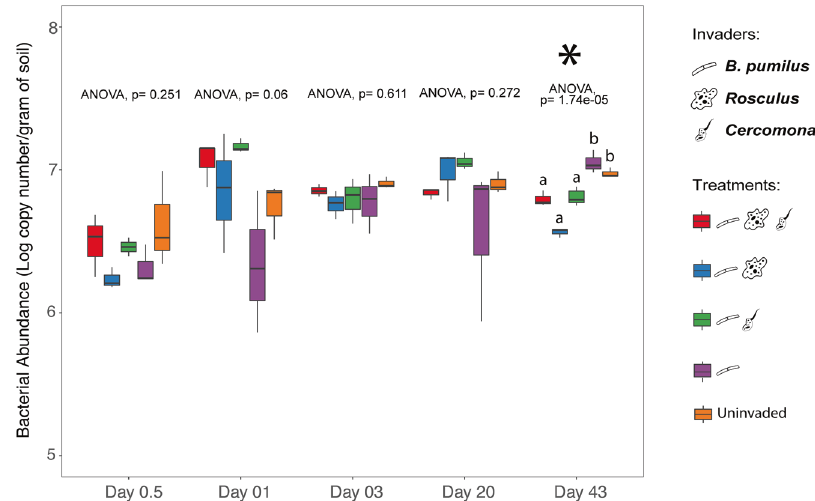
Fig. 5 Temporal dynamics of the total soil bacterial abundance between treatments in the Bacillus pumilus experiment. Values represent qPCR results in the log of 16S rRNA gene copies per gram of soil. Bars represent the standard error of the